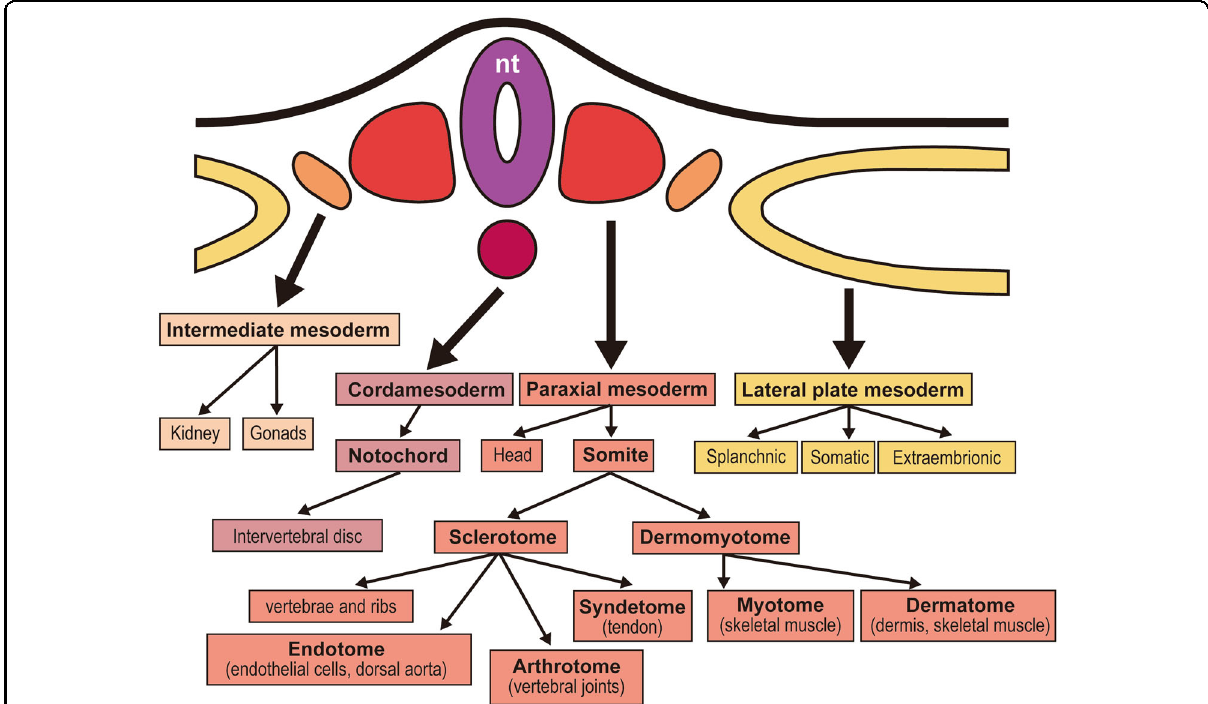
Fig. 1 Overview of the mesodermal derivatives. The chordamesoderm and paraxial mesoderm form the axial skeleton, whereas the intermediate mesoderm forms the kidneys and gonads, and the lateral plate mesoderm forms the circulating systems, body wall, and limbs (except for the musculature). nt neural tube. This fi gure is a modi fi ed version of an image from a textbook 107